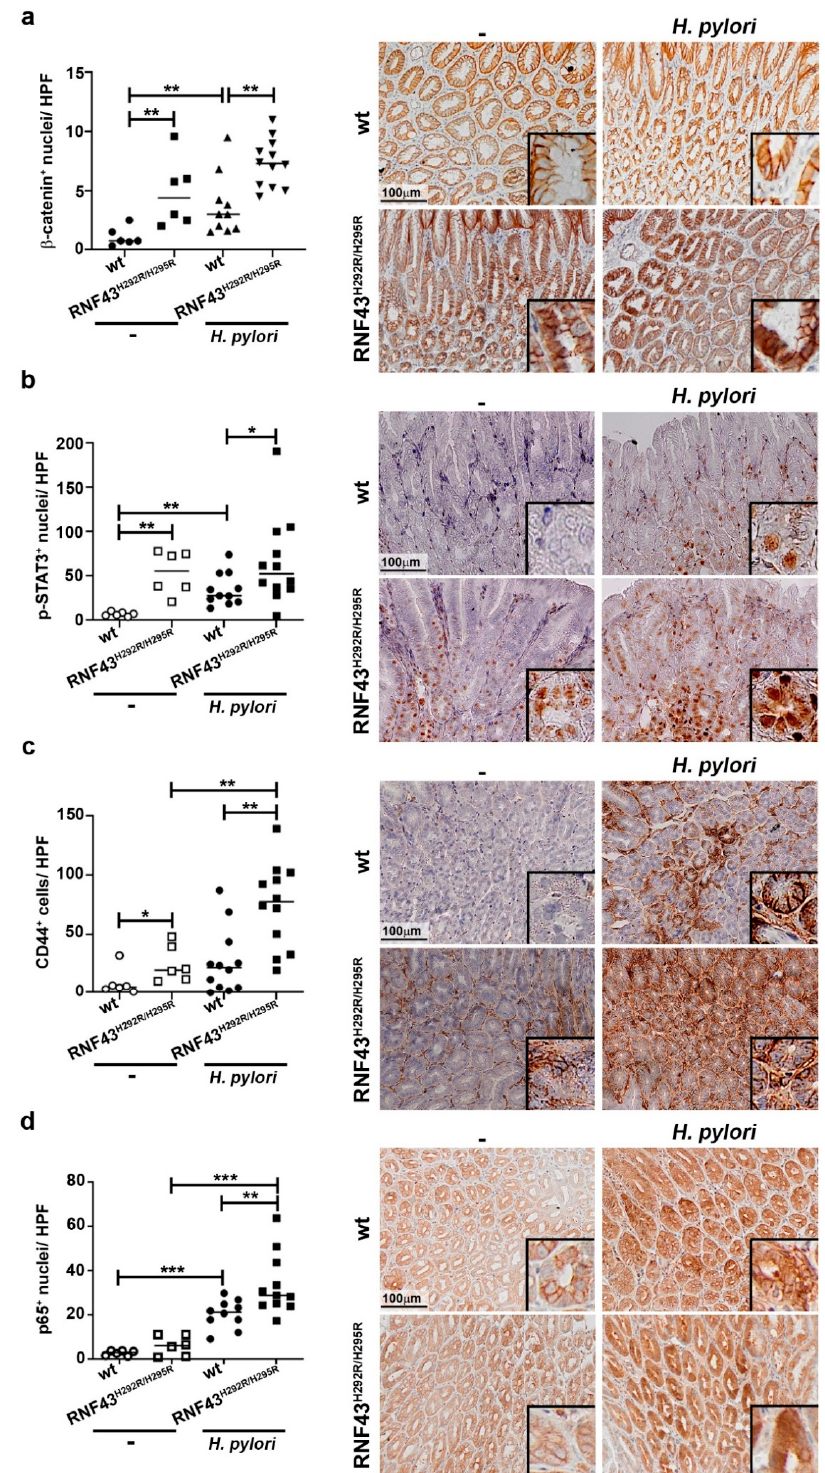
Figure 3. H. pylori enhances CD44 expression and NF- ĸ B activation in the stomach of RNF43 H292R/H295R . Number of β -catenin ( a ), p-STAT3 ( b ), CD44 ( c ) and nuclear p65 + cells ( d ) in the stomach of wild-type and RNF43 H292R/H295R mice under basal conditions and upon 6-month H. pylori infection. Representative images are shown. * p ≤ 0.05; ** p ≤ 0.01; *** p ≤ 0.001. Mann-Whitney Test (pairwise